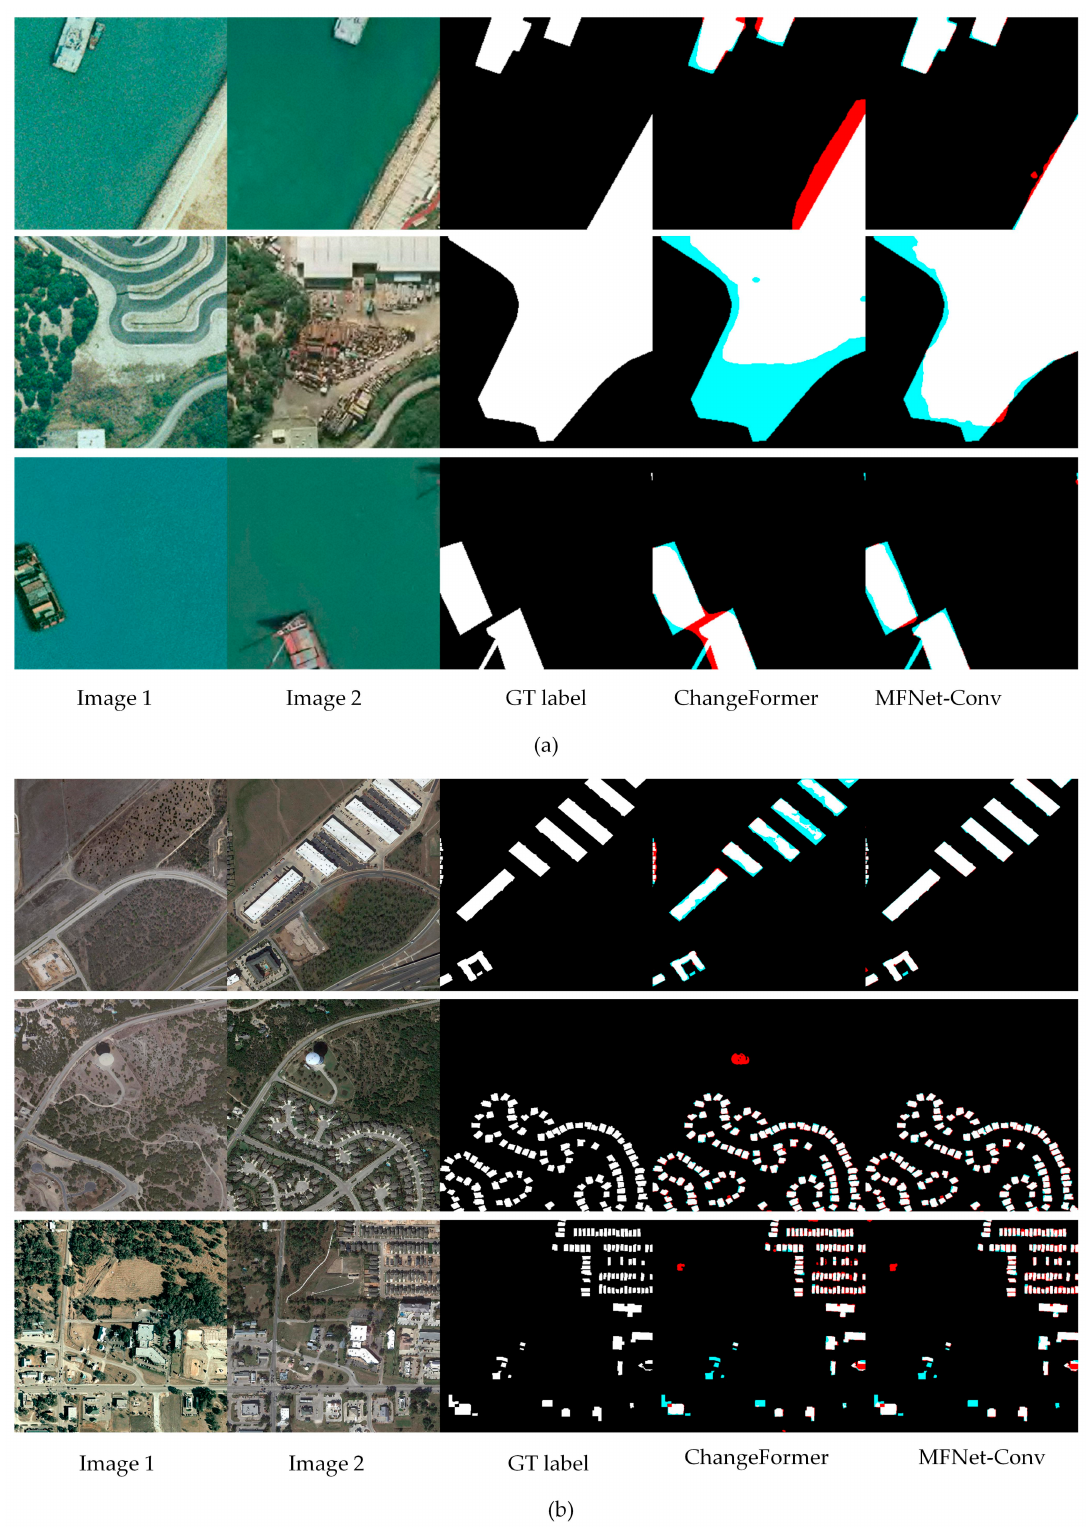
Figure 7. ( a ) Prediction results on SYSU-CD; ( b ) Prediction results on